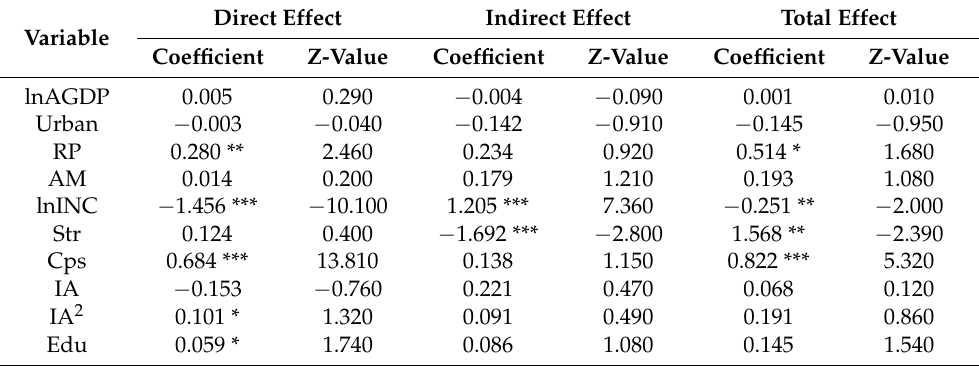
Table 9. Direct and indirect effects of the various factors on agricultural carbon